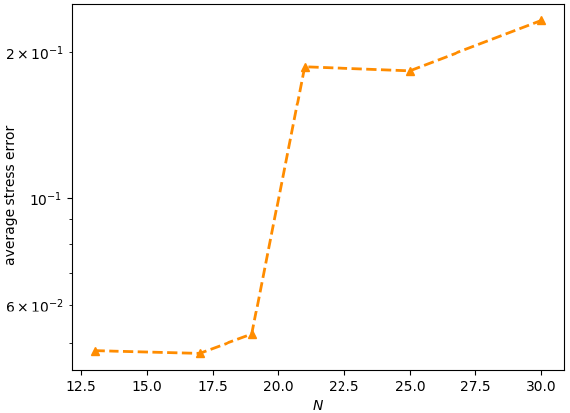
Figure 21. Average relative approximation error as a function of the number N of modes used in the online phase.